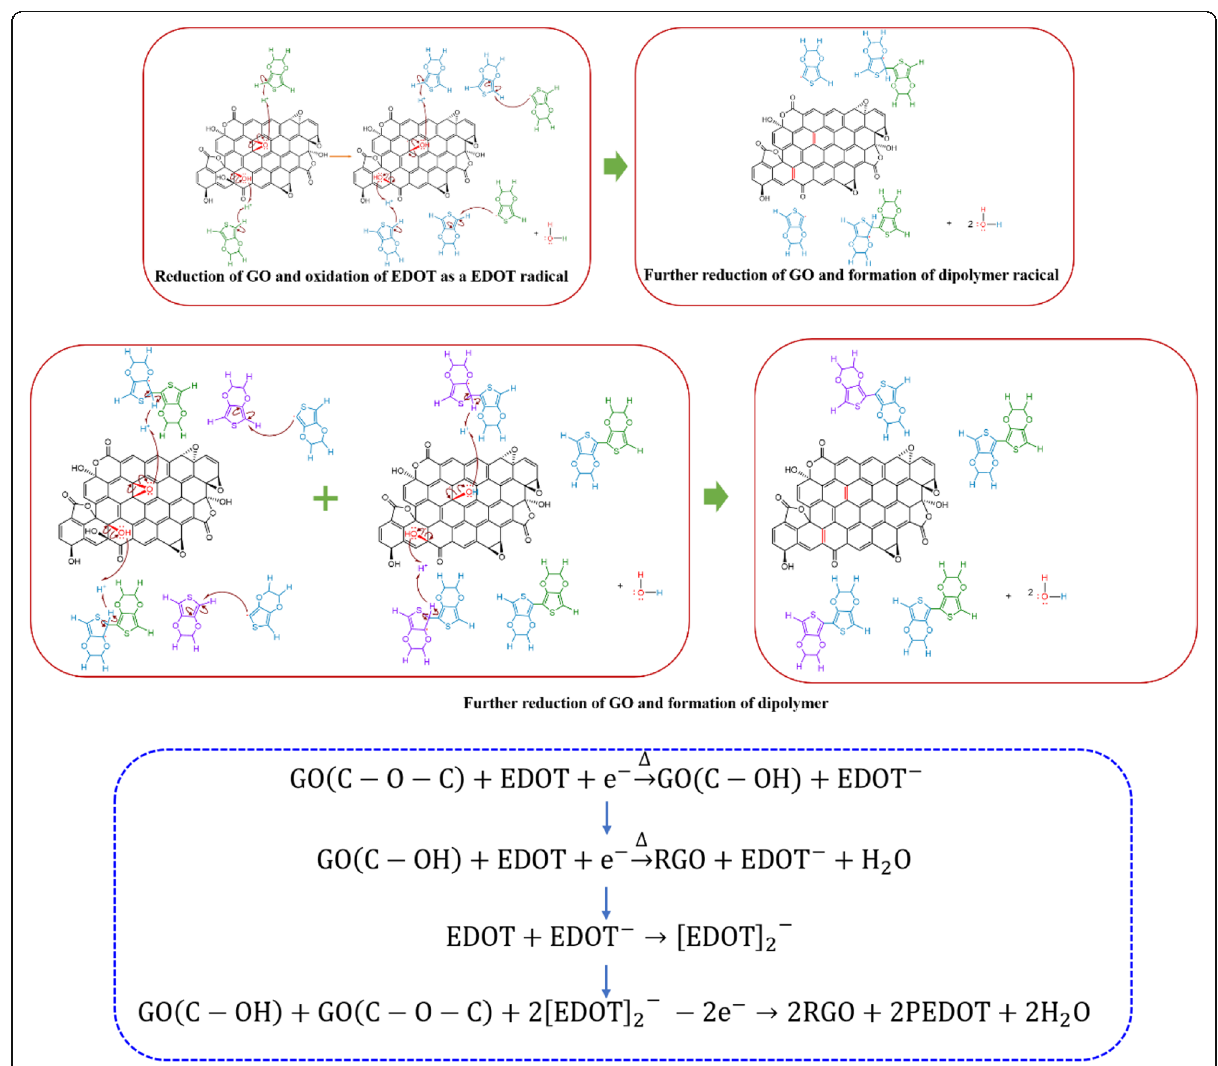
Fig. 5 The schematic of hydrothermal polymerization mechanism of